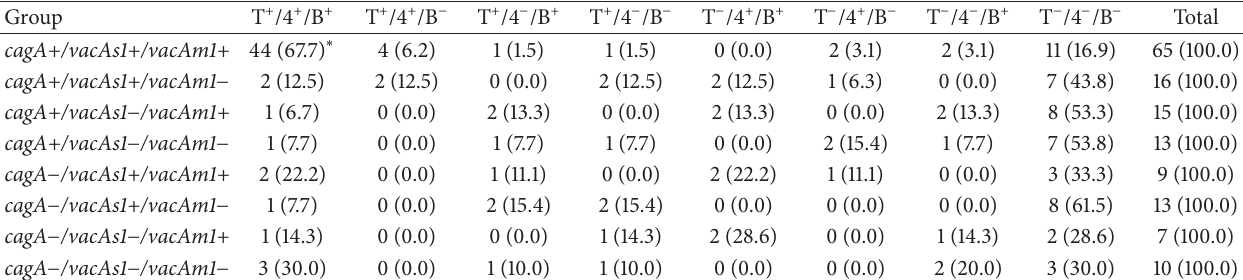
Table 3: Correlation between expression of cagA, vacAs1, and vacAm1 and TRAF1, 4-1BB, and Bcl-xL .